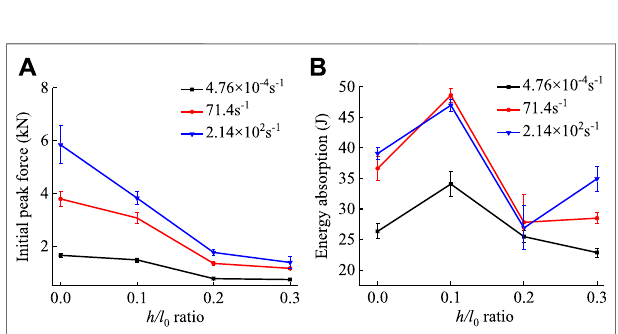
FIGURE13| Theeffects ofthetopologyonthemechanicalpropertiesof thesefoams. (A) Thequasi-staticforce-displacementcurvesforthefourtypes of foams. (B) The peak force- h/l 0 ratio curves under different strain rates.